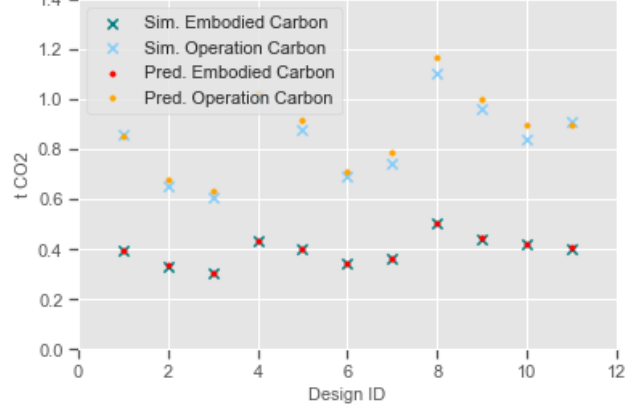
Figure 16. Testing the trained NN (Neural Network) model has proven that it can be used on building designs never previously seen by the algorithm. In this test, 11 buildings were modelled and then validated using prediction and simulation.